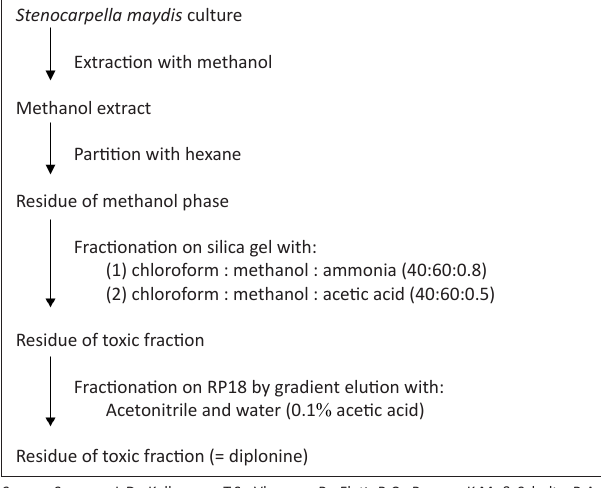
TABLE 1: Toxicity of various fractions as reflected by the severity of neurotoxic signs in a guinea pig. Fraction bio-assayed